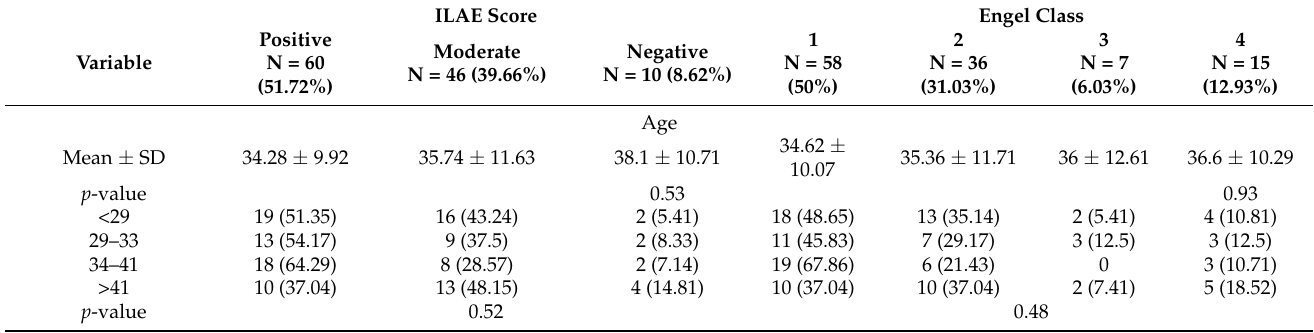
Table 4. Demographic and clinical factors associated with seizure outcomes after AVM